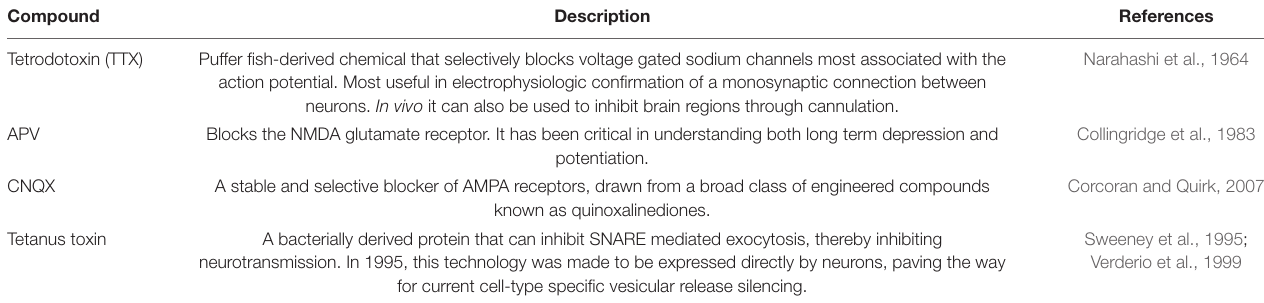
TABLE 6 | Commonly used pharmacological agents in neural circuit studies. Compound Description